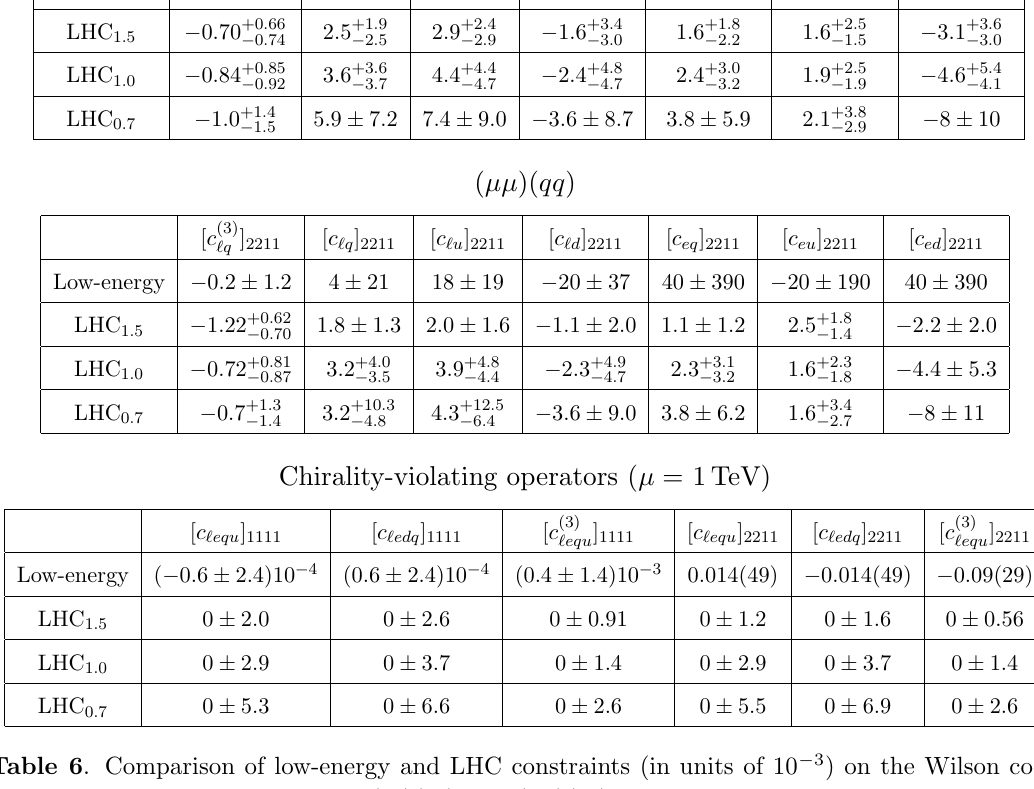
Table 6 . Comparison of low-energy and LHC constraints (in units of 10 (cid:0) 3 ) on the Wilson coef- (cid:12)cients of the chirality-conserving ( ee )( qq ) and ( (cid:22)(cid:22) )( qq ) and chirality-violating operators de(cid:12)ned at the scale (cid:22) = 1 TeV. The 68% CL bounds are derived assuming only one 4-fermion operator is present at a time, and that the vertex corrections and [ c ‘‘ ] 1221 are absent. The low-energy con- straints combine all experimental input summarized in table 4. The LHC 1 : 5 constraints use the m ‘‘ 2 [0 : 5-1 : 5] TeV bins of the measured di(cid:11)erential e + e (cid:0) and (cid:22) + (cid:22) (cid:0) cross sections at the 8